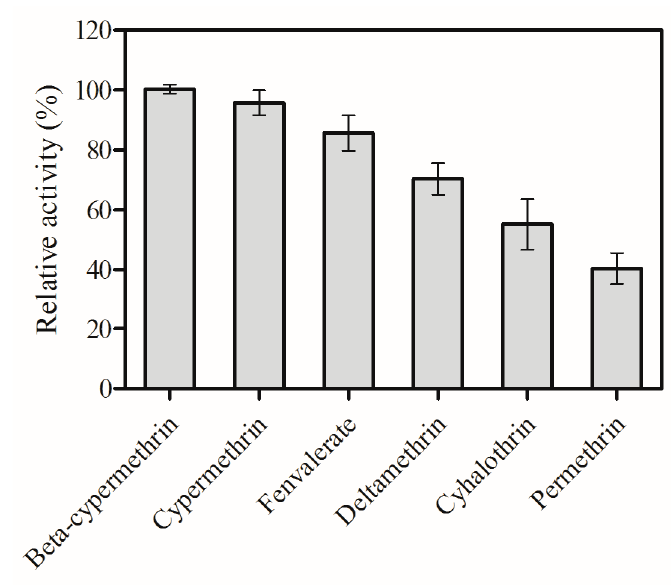
Figure 5. The relative activity of EstA to various pyrethroid insecticides.